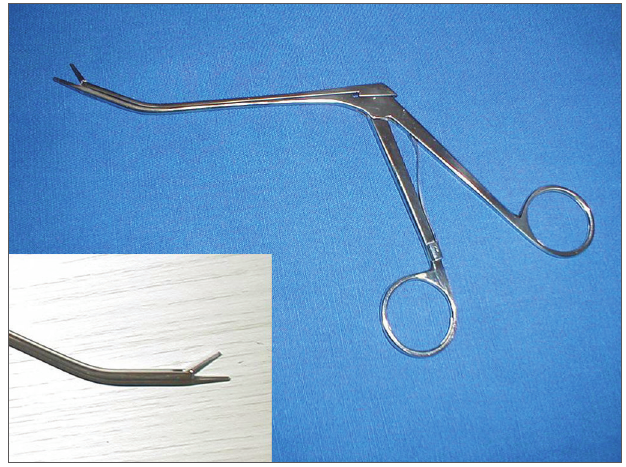
Figura 2. Pinça Ligclip com design angulado utilizada nos procedi- mentos e detalhe de sua extremidade.